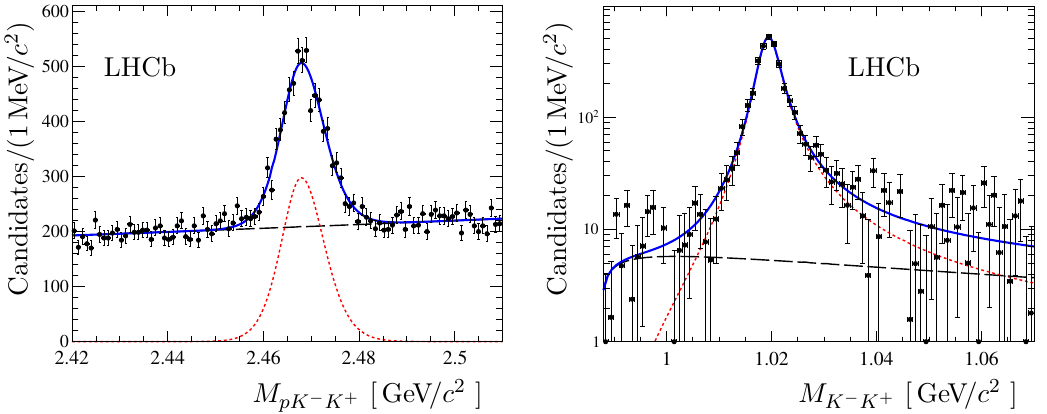
Figure 2 . (Left) Fit results for the (cid:4) + ! pK (cid:0) K + decay. The candidates are selected in the (cid:30) c meson region, i.e. with the requirement of M < 1 : 07 GeV =c 2 . The red dotted line corresponds K (cid:0) K + to the signal component, the black dashed line re(cid:13)ects the background distribution, and the blue solid line is their sum. (Right) Background subtracted K (cid:0) K + mass distribution for the (cid:4) + ! c pK (cid:0) K + decay. The red dotted line shows the (cid:4) + ! p(cid:30) contribution, the black dashed line c represents the non- (cid:30) contribution, and the solid blue line is the total (cid:12)t function.